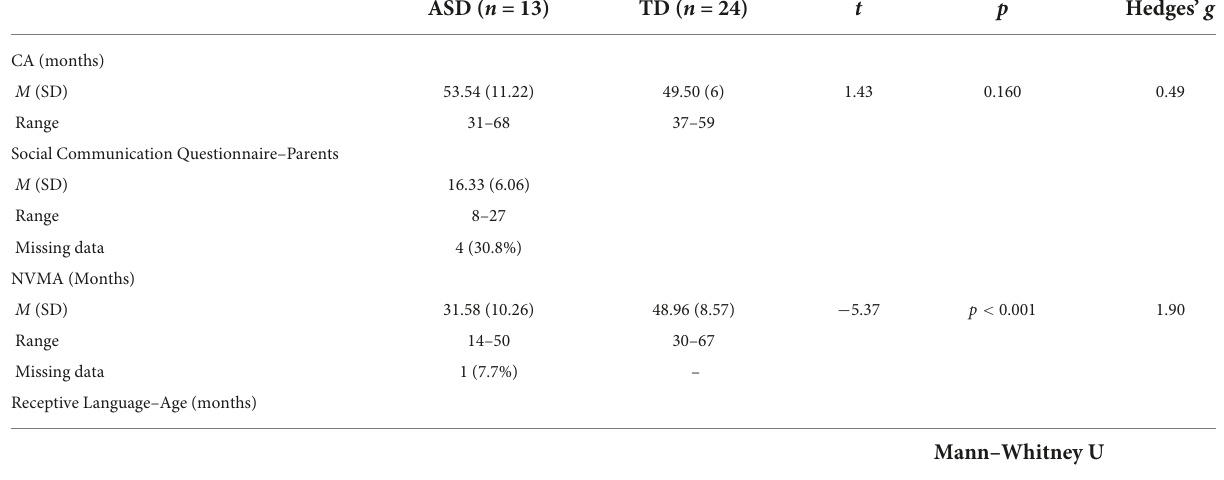
TABLE 1 Descriptive statistics for the typically developing (TD) and autism spectrum disorder (ASD)